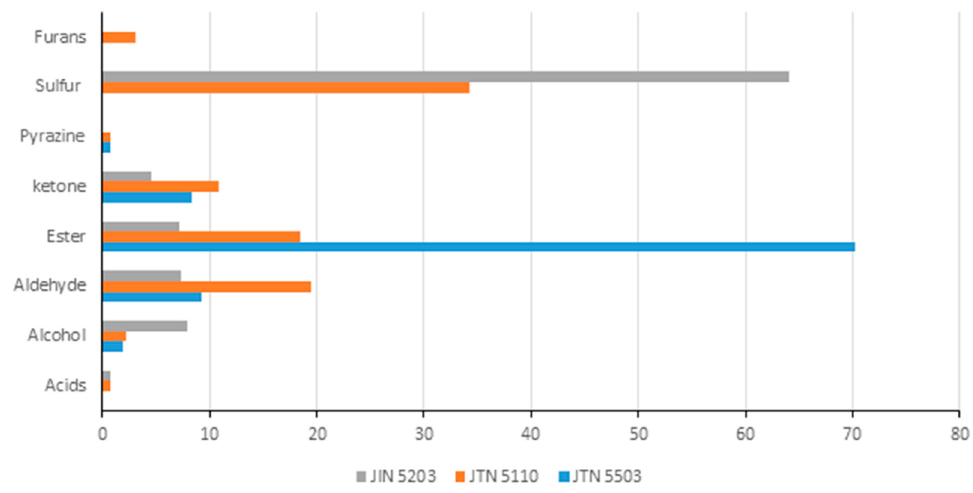
Figure 5. Comparison of volatile compounds in soybean varieties: JTN5503, JTN5110, JTN5203.